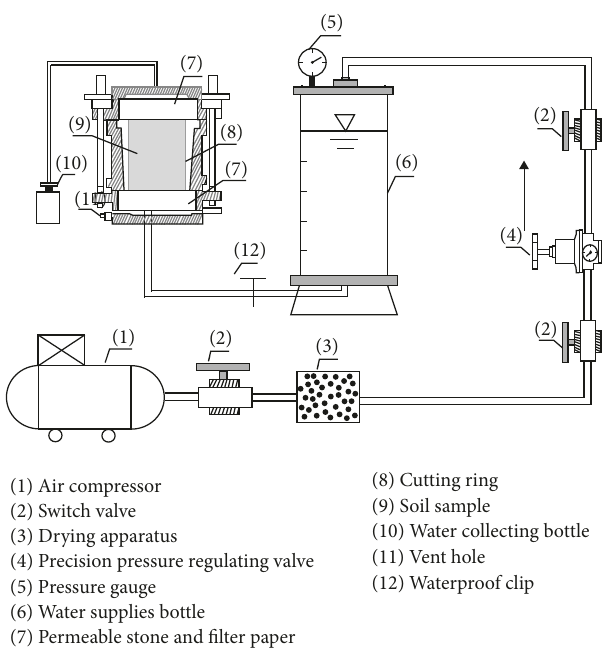
Figure5:Deviceformeasuringthe 𝐾